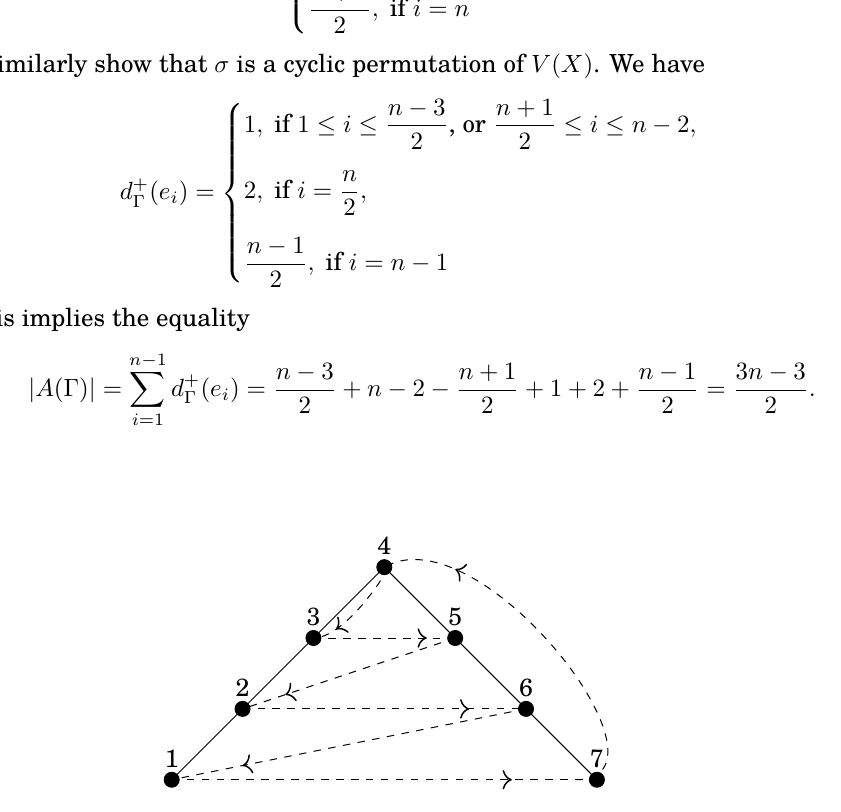
which attains the lower bound from Theorem 7